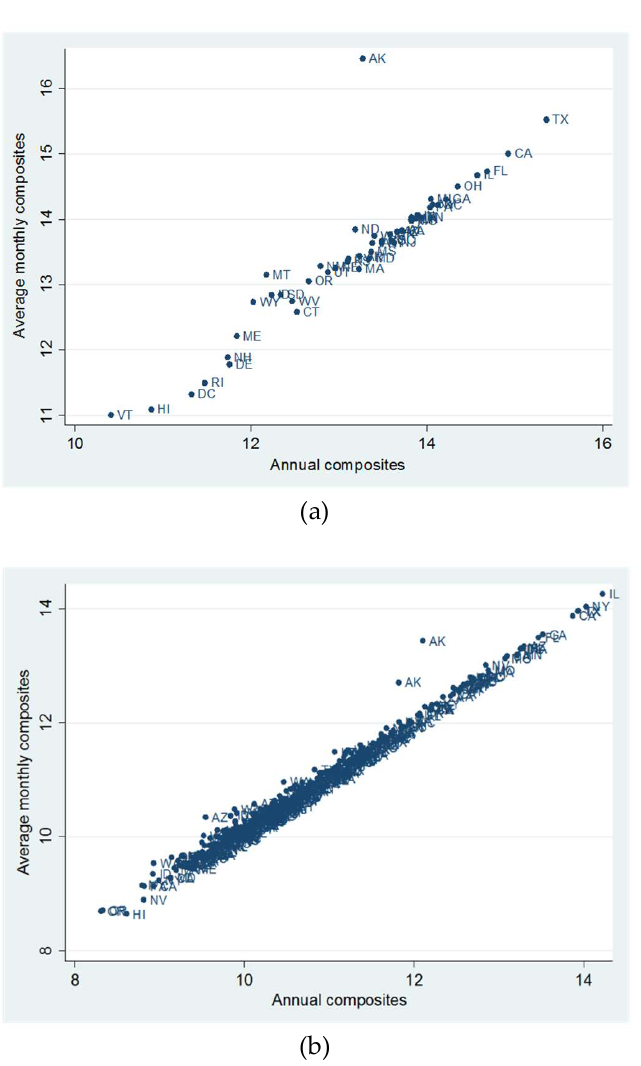
Figure 1. Average monthly composite and annual composite lights for states (2016) ( a ) and MSAs (2016) ( b ).